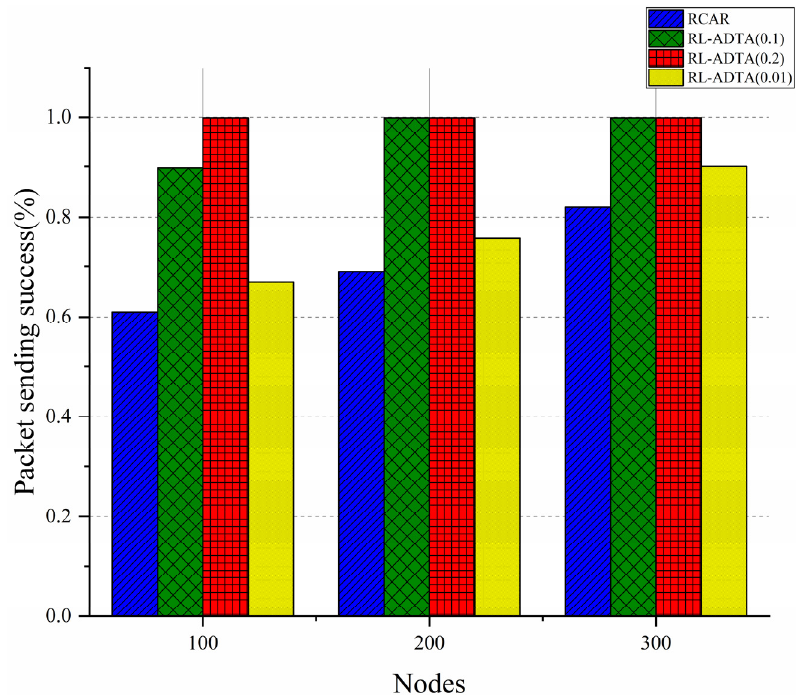
Figure 15. Comparison of packet-sending success rate of RCAR and RL-ADTA (0.1, 0.2, 0.01). Packet -sending success rate refers to the ratio of the data received and recovered by the sink node to the data sent and collected by the sensor node.